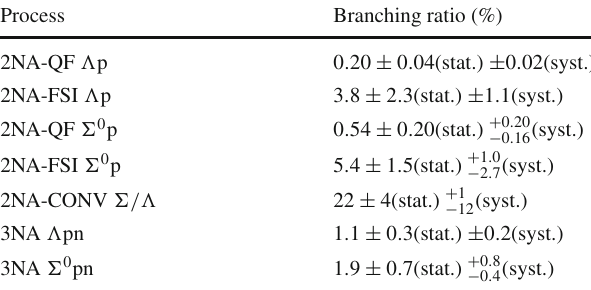
Table 4 The branching ratios of K − multi-nucleon absorptions for a back-to-back (a la FINUDA) selection of (cid:2) and p are reported together with the statistical and systematic errors